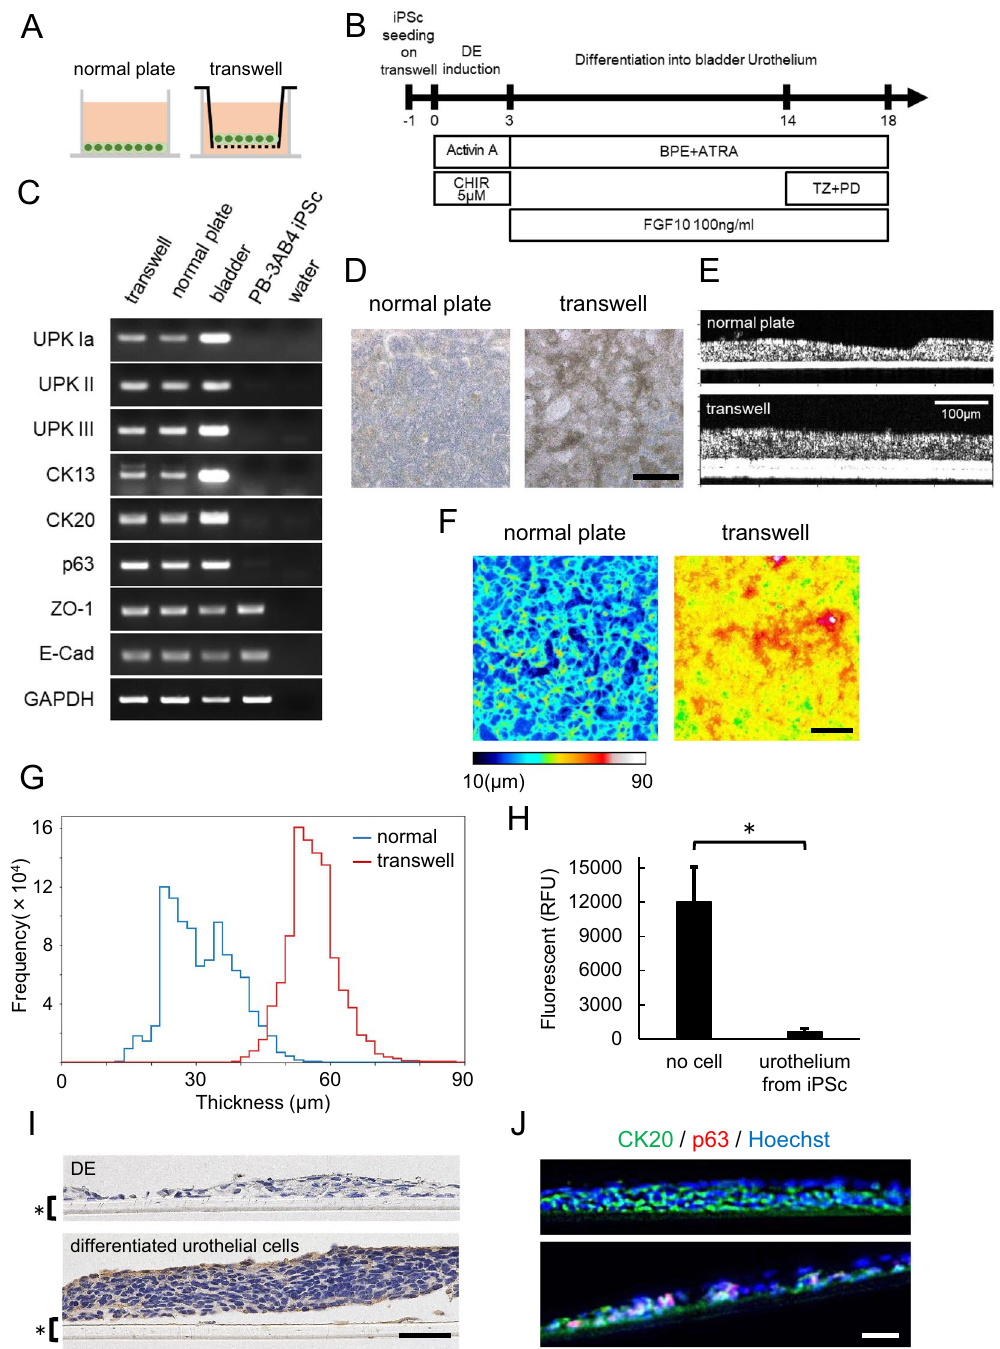
Figure 6. Transwell culture generated more stratified epithelium than normal plate culture. ( A ) Schematic images of normal plate culture (left) and transwell culture (right) for urothelial differentiation. ( B ) An overview of the culture protocol on transwell. ( C ) A semi-quantitative RT-PCR analysis of urothelial markers (UPK Ia, UPK II, UPK III), transitional differentiation markers (CK13, CK20) and other differentiation markers (p63, ZO-1 and E-Cadherin) in differentiated cells cultured in the normal plates and transwells. Total RNA of human bladder tissue was used as a positive control. Full-length gels are presented in Supplementary Figure 7. ( D ) Phase contrast images of differentiated cells at day 18 on normal plate (left panel) and transwell (right panel). Scale bar, 500 μ m. ( E ) OCT images of differentiated cells on normal plate (upper panel) and transwell (lower panel). ( F ) The thicknesses of the differentiated cells on normal plate (right panel) or transwell (left panel) were visualized using a color-scale heatmap from 10 to 90 µ m in low-resolution mode. Scale bar, 1 mm. ( G ) the histogram distribution of the OCT analysis of differentiated cells on normal plate (blue line) and transwell (red line) in low-resolution mode. ( H ) An in vitro permeability assay using FITC dextran. Fluorescence intensities were quantified by relative fluorescence units (RFU) (n = 3 independent experiments; mean ± SEM, * p < 0.05; two-tailed paired t -test). ( I ) Immunostaining of UPK II in DE cells (upper panel) and